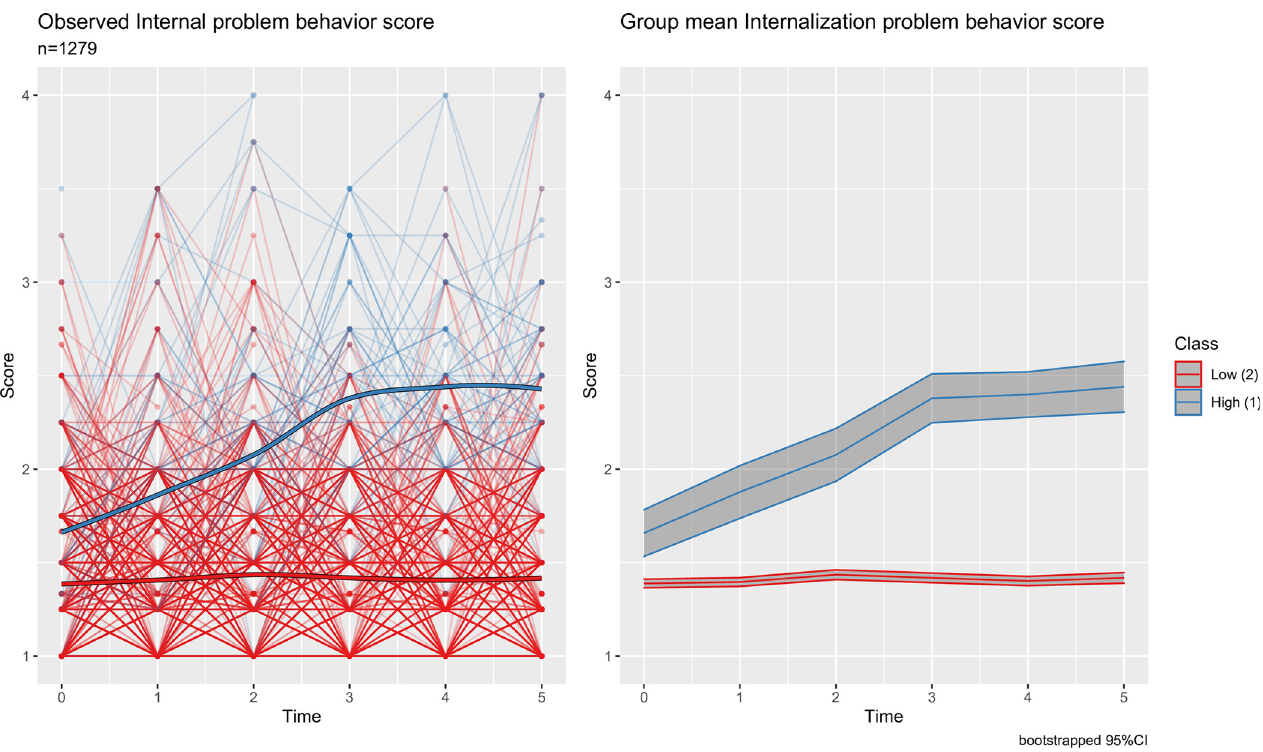
Fig 2. Longitudinal trajectories of internalizing problem behavior scores. Left panel shows individual observed trajectories with dark line representing the mean for each latent class. Right panel shows class mean with shaded region representing the bootstrapped 95% confidence band.